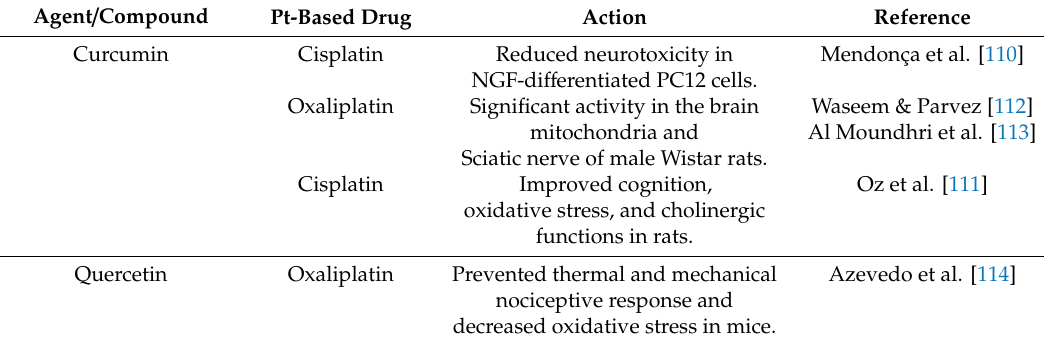
Table 3. Compounds from natural sources, natural products, and medicinal plants with promising protective activity against platinum-drugs induced